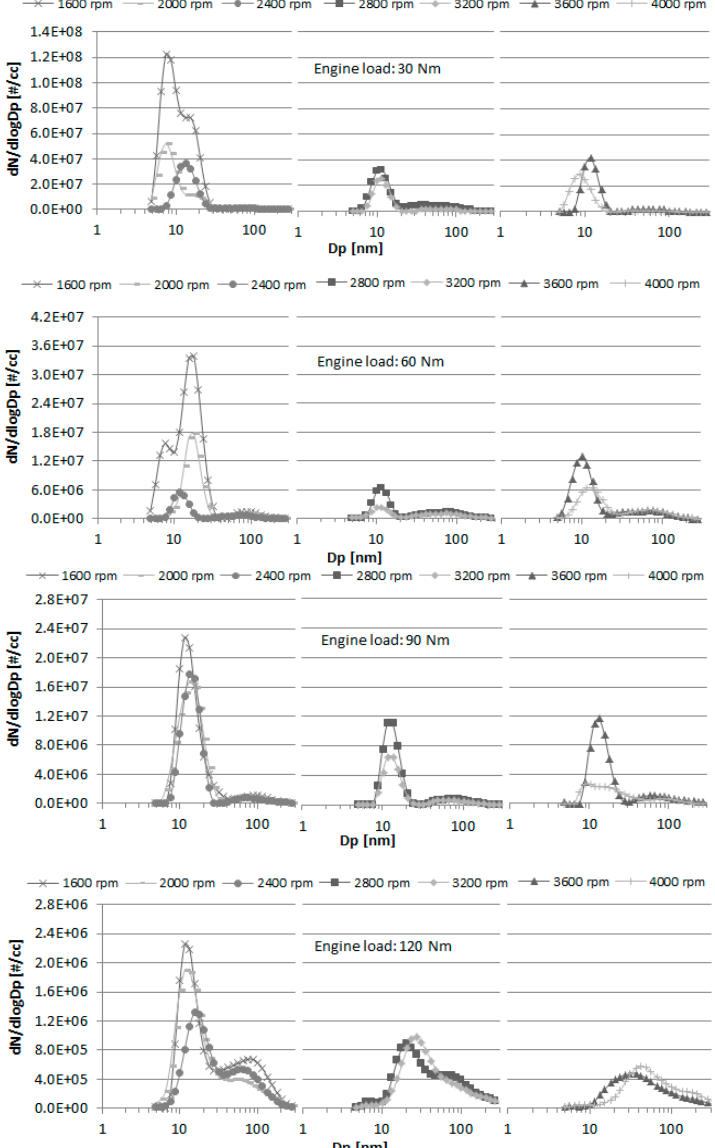
Figure 4. Measured size-resolved particle number density distributions for all the experimental conditions investigated in this work. Engine speed is varied between 1600 and 4000 rpm, at each of four engine torque levels (30, 60, 90, 120 Nm).